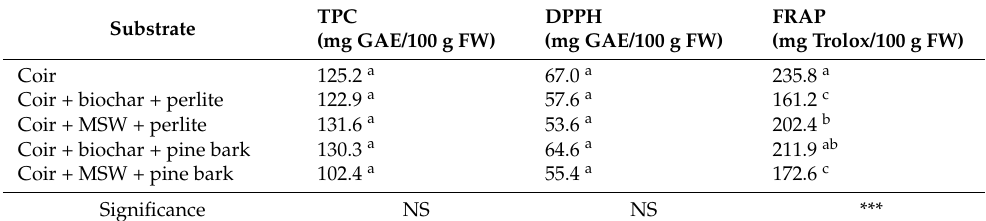
Table 6. Effect of substrates on total phenols content and antioxidant activity.